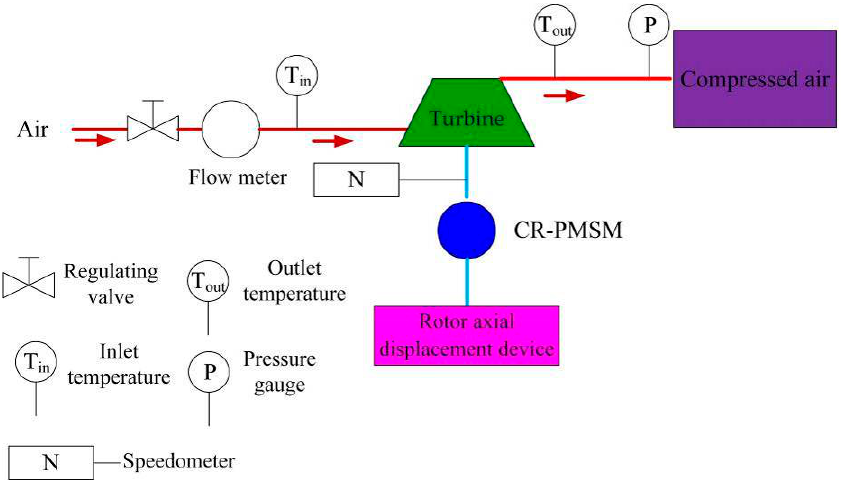
Figure 15. Performance test flowchart of CR-PMSM direct-driven turbo-compressor.